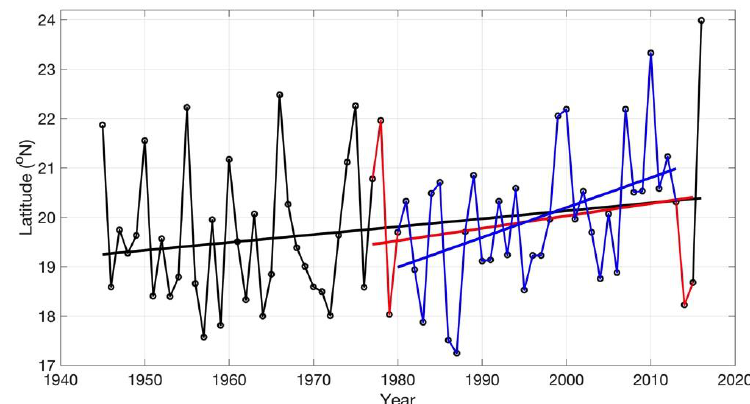
Figure 1. Time series of residuals after regressing the annual-mean latitude of peak western North Pacific tropical cyclones (TC) intensity onto Pacific Decadal Oscillation (PDO) and El Niño/Southern Oscillation (ENSO) indices (July–November mean). The statistics shown (poleward migration rate, two-sided 95% confidence interval, and p -value) are based on the period 1945–2015. The residual for 2016, which had the northern-most mean latitude of peak TC intensity ever recorded in the western North Pacific best-track (see Figure 2 below), is shown by the red dot (this point is not included in the regression). Gray shading shows the two-sided 95% confidence bounds on the trend.